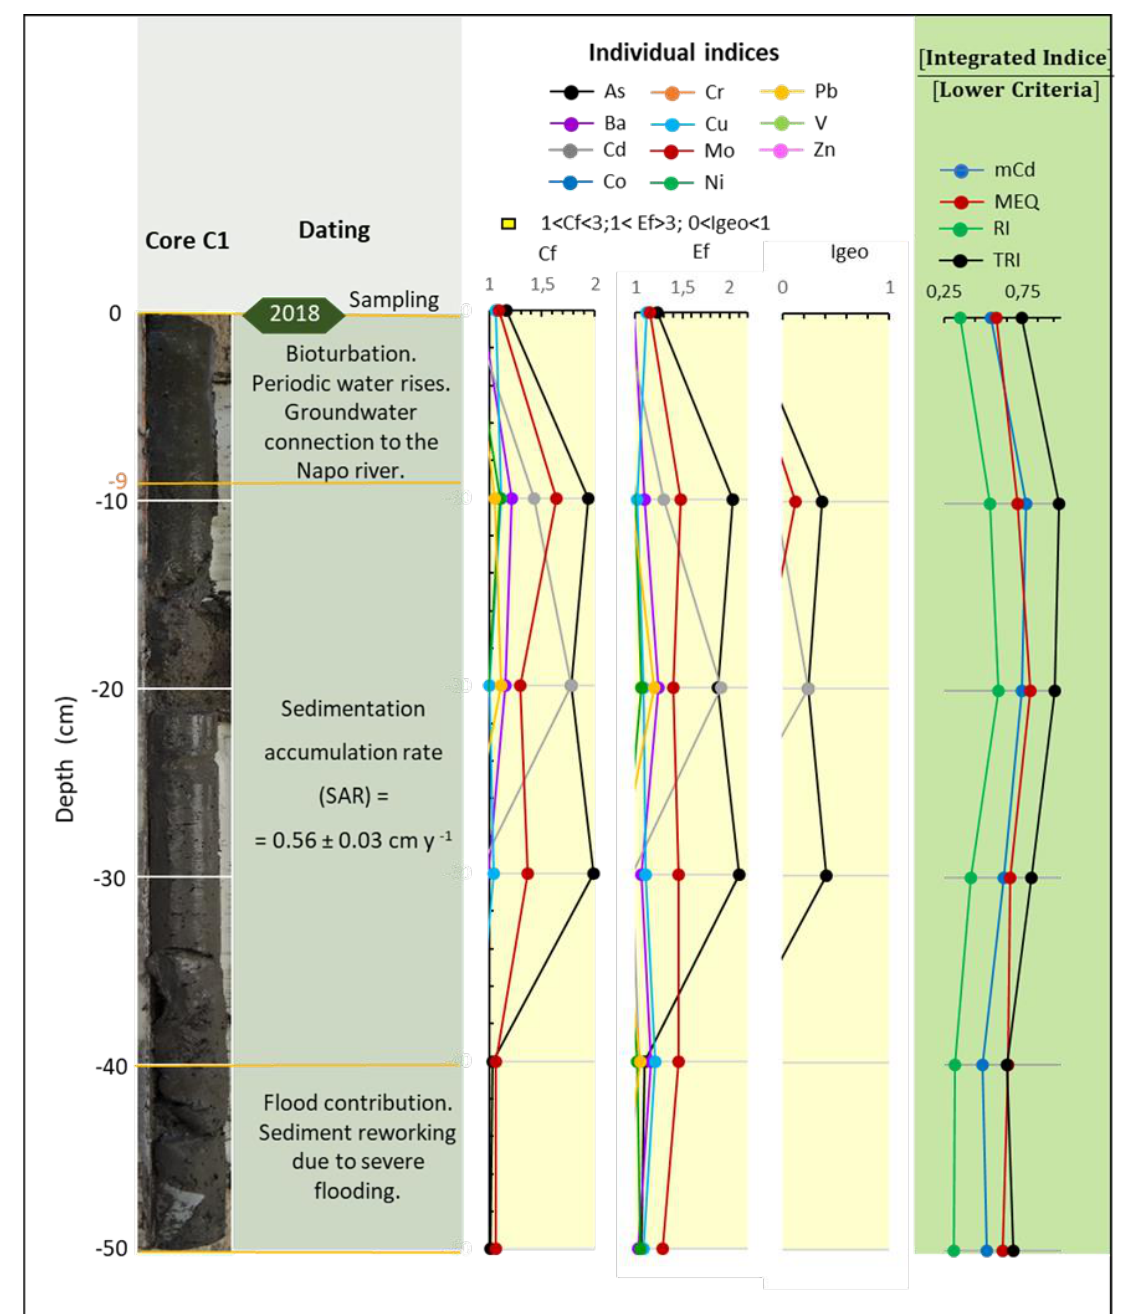
Figure 10. Dating together with plausible events that occurred in the sections under study and the values of the individual and integrated pollution indices compared with the lower indicative limits of contamination in each